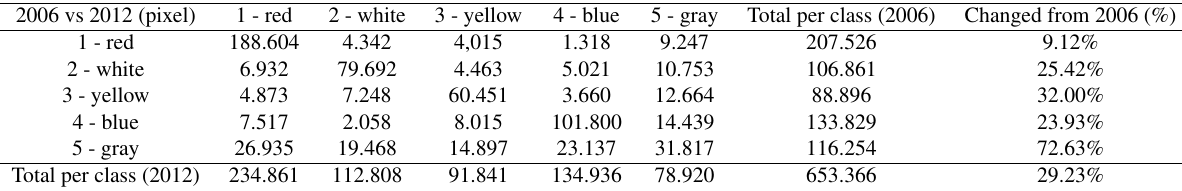
Table 5. Per pixel comparison between 2006 and 2012